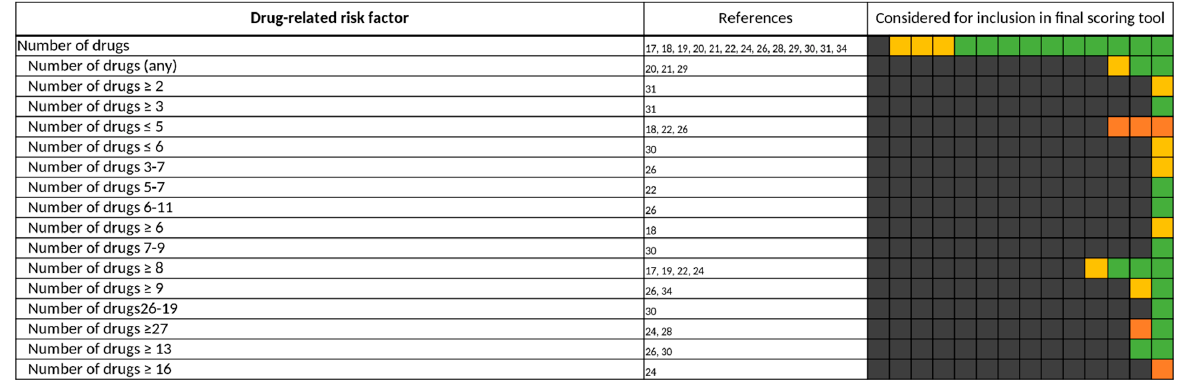
Figure 4. All different thresholds investigated by the authors of the included studies for “number of drugs”. Each of the 14 boxes represents one of the included studies. The color of the boxes por- trays whether a risk factor was not investigated in a study (gray), was investigated (orange), was significant in a first statistical analysis or based on expert consensus and therefore tested for inclu- sion in a final scoring tool (yellow), or whether a risk factor was included in a final scoring tool (green). The “citations”-column lists each study that at least investigated the respective risk factor.